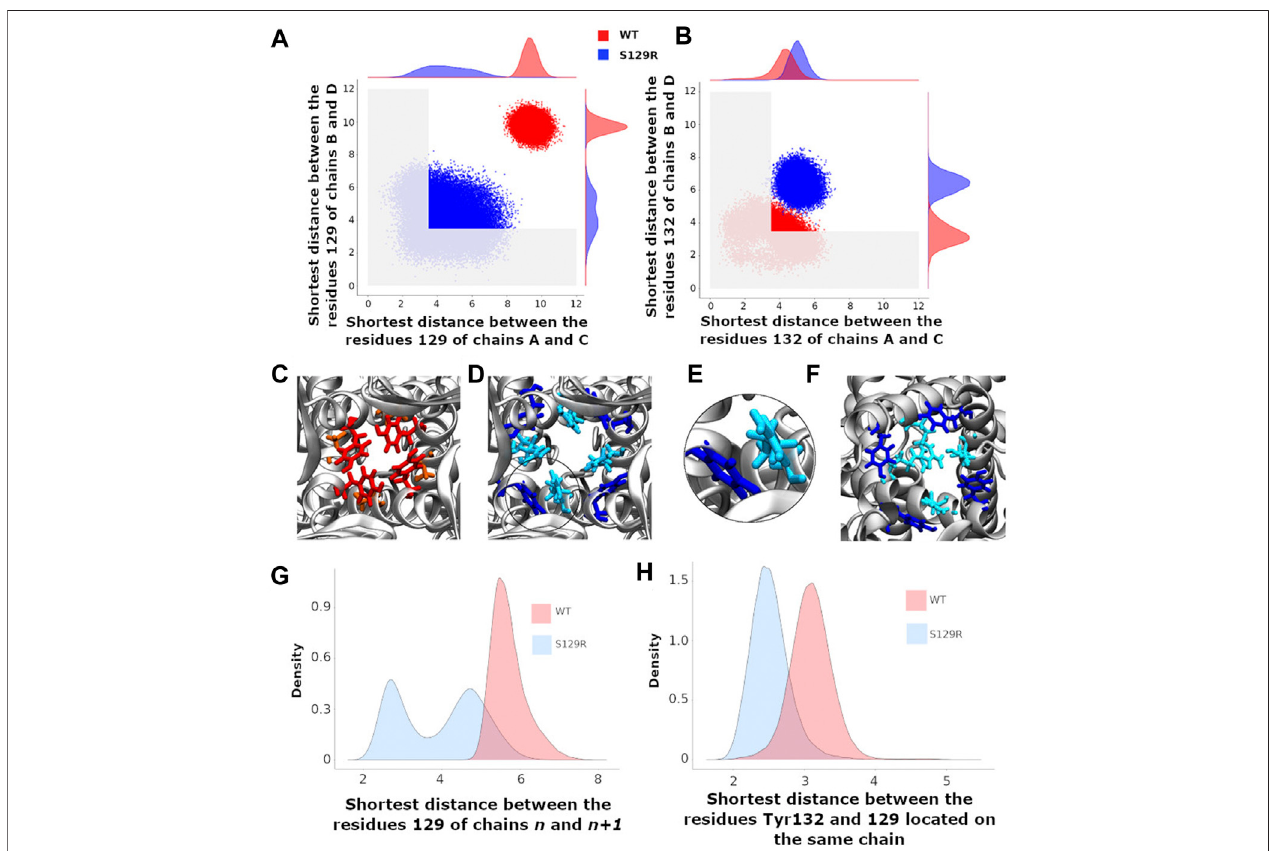
FIGURE3| GatingatthemutationS129RandattheconstrictionpointTyr132 (A) ScatterplotsoftheshortestdistancesbetweenthechainsBandDandbetween A and C at the level of the residue 129. The shortest distance between two residues is that between their respective atoms including the hydrogens; (B) Scatter plots of the shortest distances between the chains B and D and between A and C at the level of the residue Tyr132. A,B) Red and blue points correspond to the KirBac3.1 WT and KirBac3.1 S129R, respectively. The gray area delimits the region where the channel is closed (C – F) : representative relaxed structures; (C) Locations of the residuesTyr132(red)andSer129(orange)inKirBac3.1WT; (D) LocationsoftheresiduesTyr132(darkblue)andArg129(cyan)inKirBac3.1S129R; (E) ZoomontheVan der Waals contacts between Tyr132 and Arg129 in KirBac3.1 S129R; (F) Locations of the residues Tyr132 (dark blue) and Arg129 (cyan) pointing toward the center of thechannelinKirBac3.1S129R; (G) Histogramsoftheshortestdistancebetweenresidue129ofthechain n andtheresidue129ofthechain n +1; (H) Histogramsofthe values of the shortest distances between the residues 129 and Tyr132 from the same chain. The histograms in panels (G,H) were established by taking into account all the